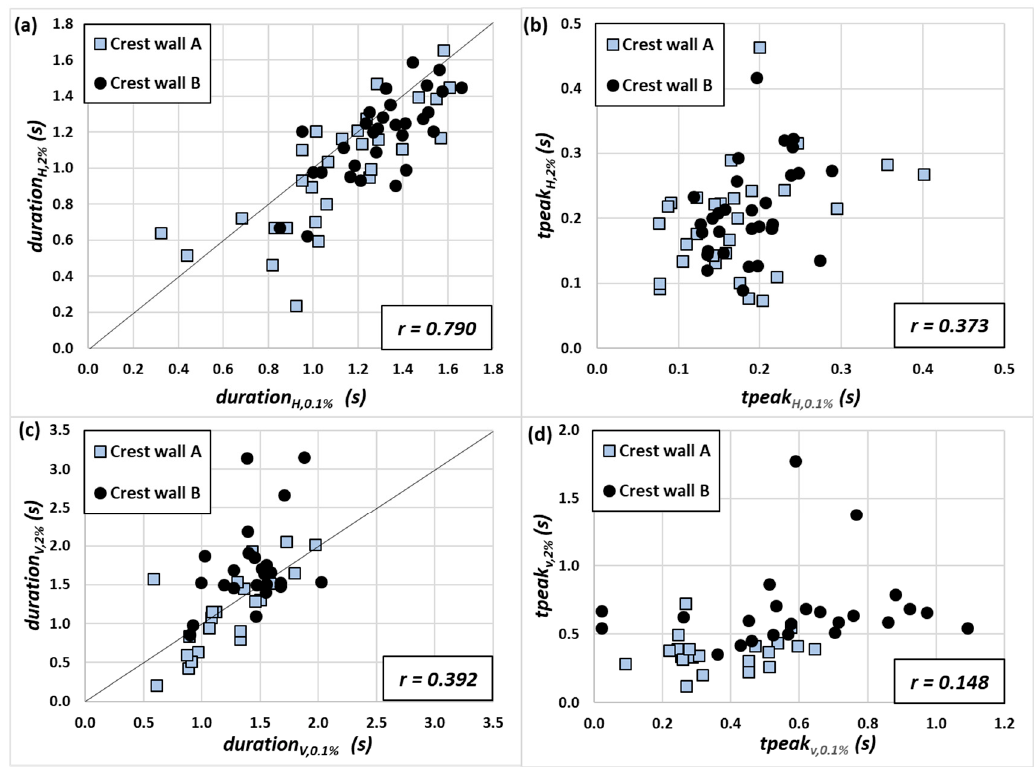
Figure 7. Comparison between: ( a ) duration of the horizontal force event exceeded by 0.1% and 2% of incoming waves ( duration H,0.1% and duration H,2% ), ( b ) position of the peak of the horizontal force event exceeded by 0.1% and 2% of incoming waves ( tpeak H,0.1% and tpeak H,2% ), ( c ) duration of the vertical force event exceeded by 0.1% and 2% of incoming waves ( duration V,0.1% and duration V,2% ), and ( d ) position of the peak of vertical force event exceeded by 0.1% and 2% of incoming waves ( tpeak V,0.1% and tpeak V,2% ).